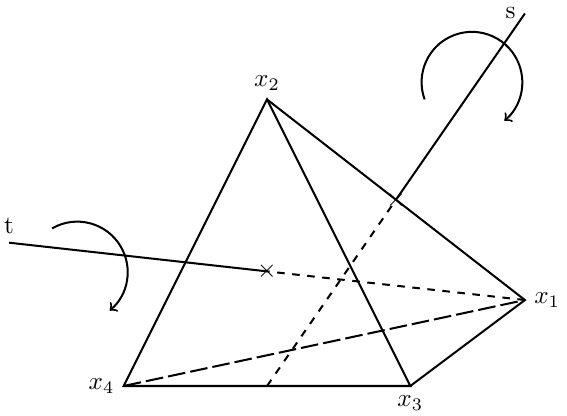
4 . A 4 can be parameterized x 2 ; x 3 x 4 , t : x 2 $ $ 7!